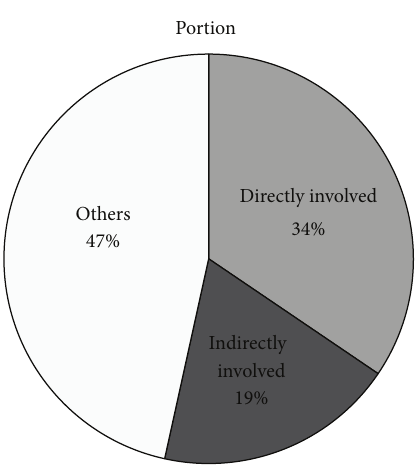
Figure 2: Components of survey respondents.